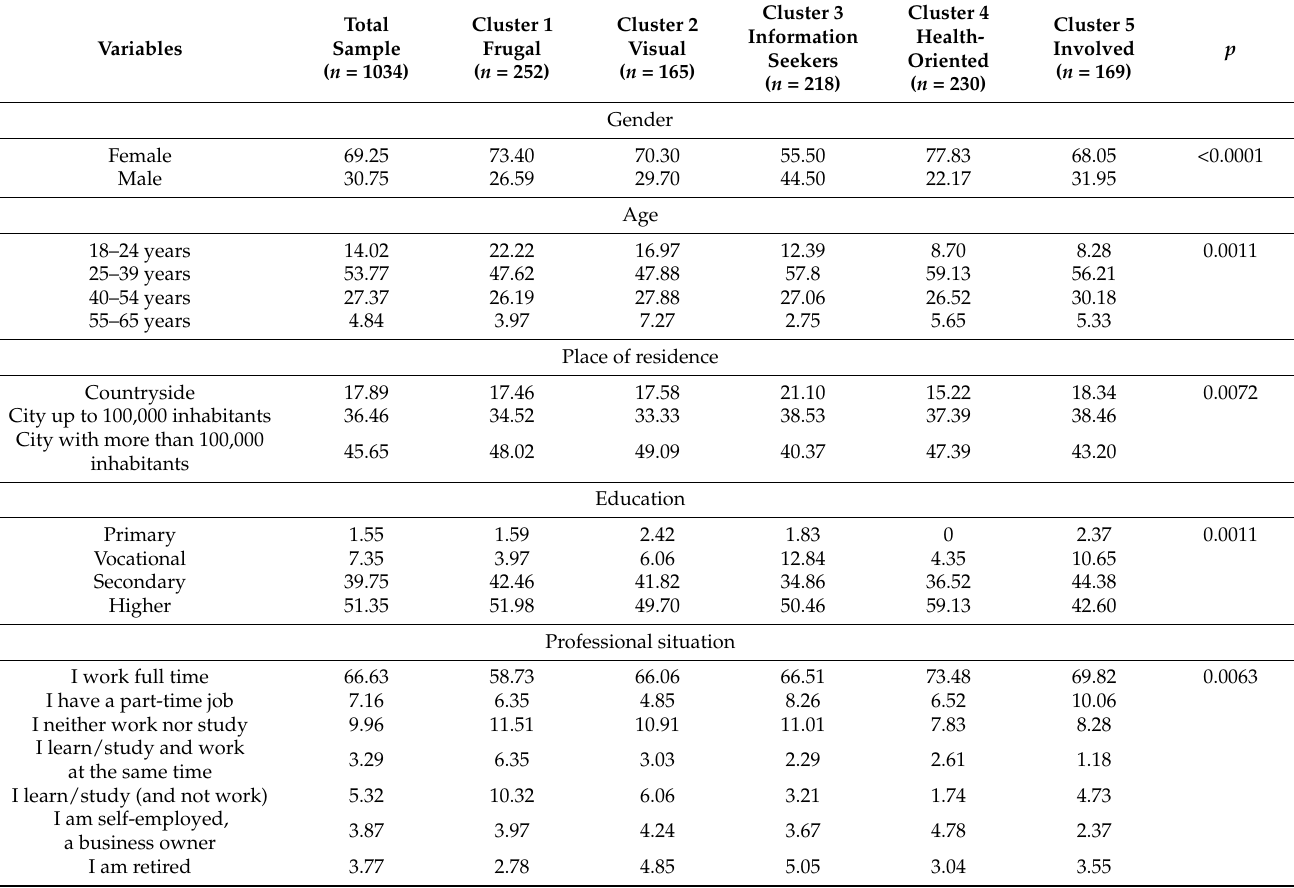
Table 4. Socio–demographic characteristics of the study sample according to clusters’ adherence (%, n = 1034,